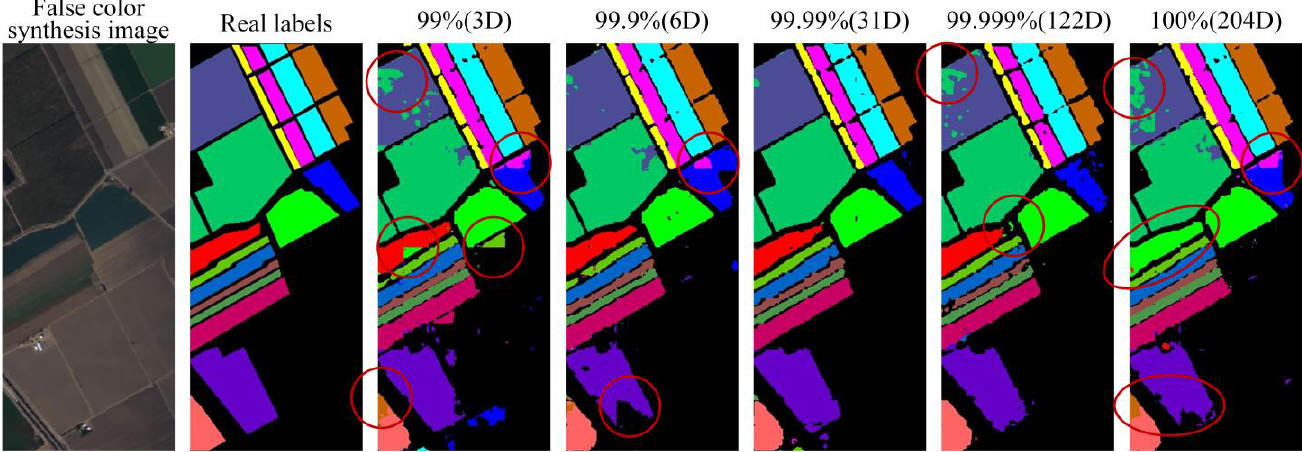
Figure 6. Comparison of visualized segmentation results with different CVCRs.